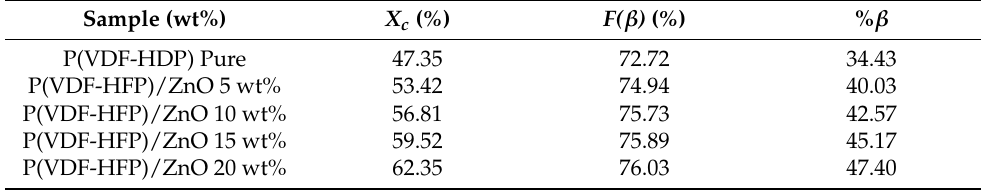
Table 1. Analysis of the crystallinity and β -phase fraction in the crystalline of the samples. Sample